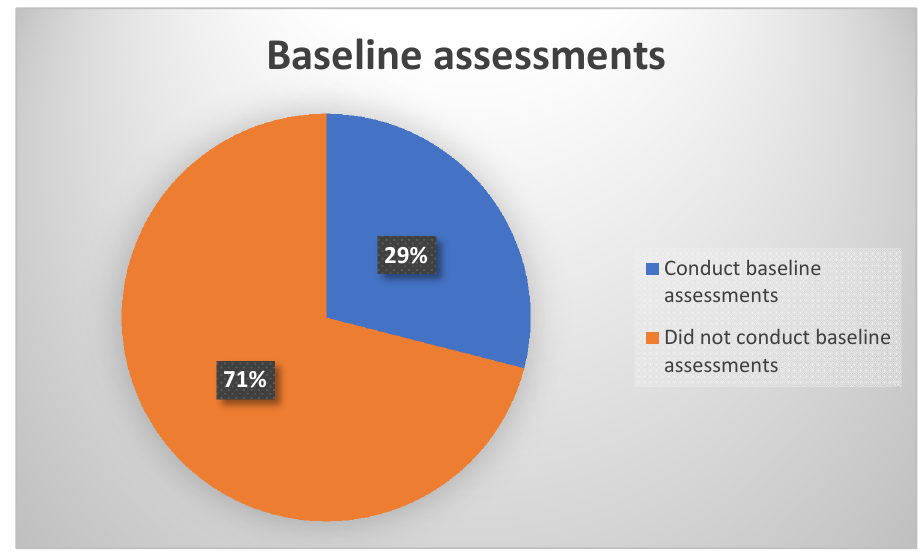
Figure 2. Audiologists’ performance of baseline assessments per patients seen.